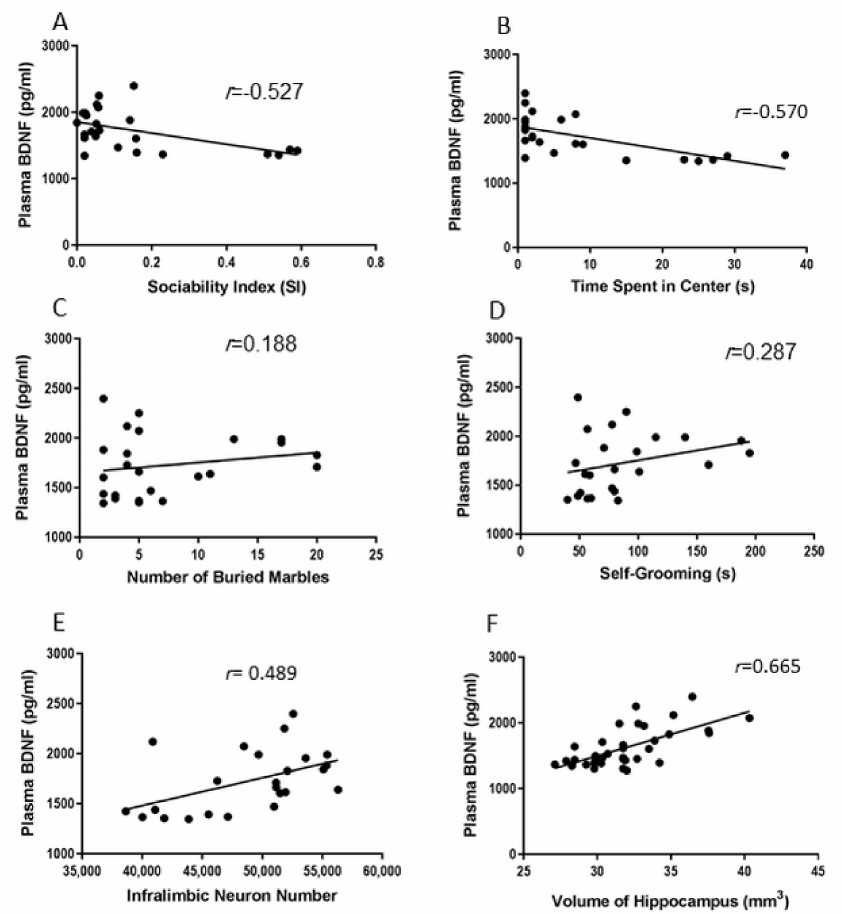
Figure 7. Significant negative correlations between plasma BDNF level and sociability index and time spent in the centre of the open field ( r = − 0.527, p = 0.009 and r = − 0.570, p = 0.001) ( A , B ). No significant correlation between repetitive behaviours (marble burying and self-grooming) and plasma BDNF level ( C , D ) was observed ( p > 0.05). Significant positive correlations between plasma BDNF level and number of the neurons in infra- limbic and volume of the hippocampus ( r = 0.489, p = 0.015 and r = 0.665, p < 0.001) ( E , F